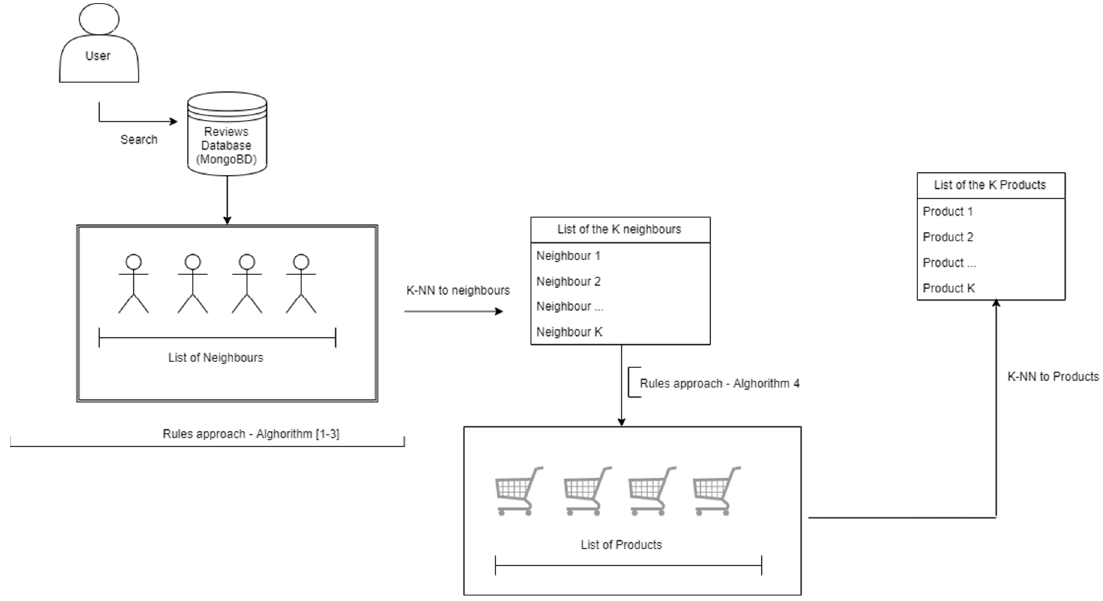
Figure 1. Overview of the hybrid ontology-based approach.